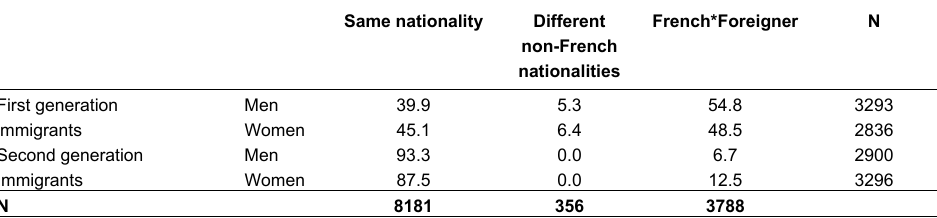
Table 2: Types of marriage (nationality criterion) Same nationality Different